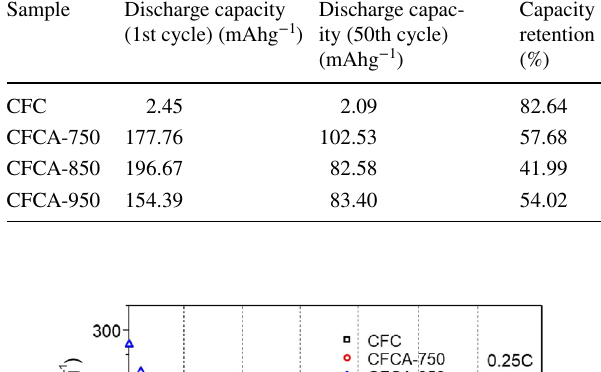
Table 5 Capacity retention of CFC and CFCAs at C/3 Sample